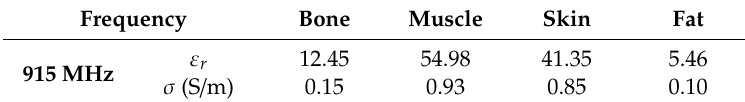
Table 1. Dielectric constants of human tissue.